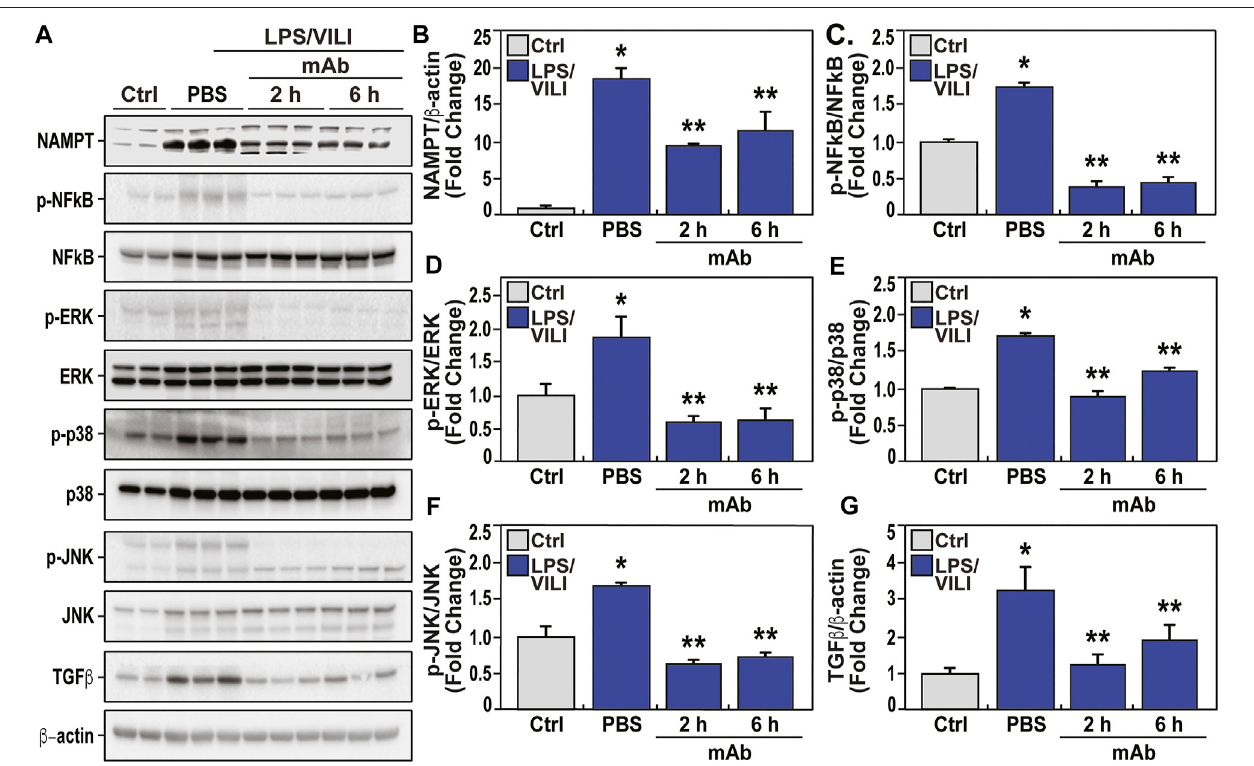
FIGURE 5 | The eNAMPT-neutralizing ALT-100 mAb attenuates dysregulated NFkB and MAP kinase signaling in an LPS/VILI porcine model. Lung tissue homogenates were obtained from PBS-treated and eNAMPT ALT-100 mAb-treated LPS/VILI-exposed pigs (n = 4/group) and compared to untreated control pigs (n = 4). (A,B) Western blot analysis con fi rmed signi fi cantly higher NAMPT expression in porcine LPS/VILI lung homogenates (lanes 3 – 5) compared to controls ( fi rst 2 lanes). The eNAMPT-neutralizing ALT-100 mAb reduced NAMPT immunoreactivity in lung homogenates both when delivered at 2 h (lanes 6 – 8) and at 6 h (lanes 9 – 11) (* p < 0.05 control vs. untreated LPS/VILI; ** p < 0.05 mAb LPS/VILI vs. untreated LPS/VILI). (A,C) Western blotting studies revealed striking increases in NFkB phosphorylation/totalNFkBlevelsinLPS/VILIporcinetissueswhichwereabolishedbyALT-100mAbwhendeliveredat2 h(lanes6 – 8)andat6 h(lanes9 – 11)con fi rmed by densitometric evaluation of the ratio of p-NFkB/NFkB shown in the bar graph (* p < 0.05 control vs. untreated LPS/VILI; ** p < 0.05 mAb LPS/VILI vs. untreated LPS/ VILI). (A,D,E,F) WesternblottingstudiesofLPS/VILI-exposedlunghomogenatesdetectedprominentMAPkinasefamilyactivationwithincreasedlevelsofERK,p38and JNK phosphorylation (pp-42/44 ERK, pp-p38, pp-JNK). MAP kinase family activation which was attenuated in pigs receiving the ALT-100 mAb delivered at 2 h (lanes 6 – 8) or 6 h (lanes 9 – 11) (* p < 0.05 control vs. untreated LPS/VILI; ** p < 0.05 mAb LPS/VILI vs. untreated LPS/VILI. (A,G) Total TGF ꞵ protein levels in LPS/VILI lung homogenates were markedly increased and reduced in pigs receiving the eNAMPT-neutralizing ALT0-100 mAb shown by densitometric assessment (* p < 0.05 control vs. untreated LPS/VILI; ** p < 0.05 mAb sepsis/VILI vs. untreated LPS/VILI).